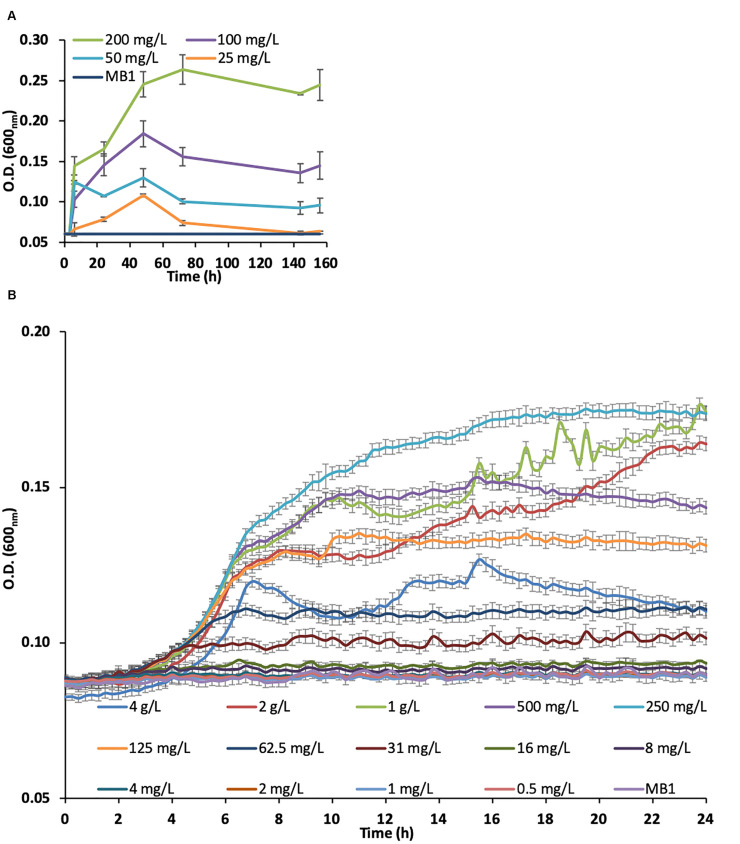
Growth curves of the bacterial consortium on SLES enrichment cultures measured by optical density (O.D.) at 600 nm. (A) Enrichment cultures at 4 SLES concentrations (25, 50, 100, and 200 mg/L). (B) Bacterial consortium, from the enrichment cultures at 200 mg/L, tested at 14 SLES concentrations. The vertical bars are the standard errors. MB1 = negative control.